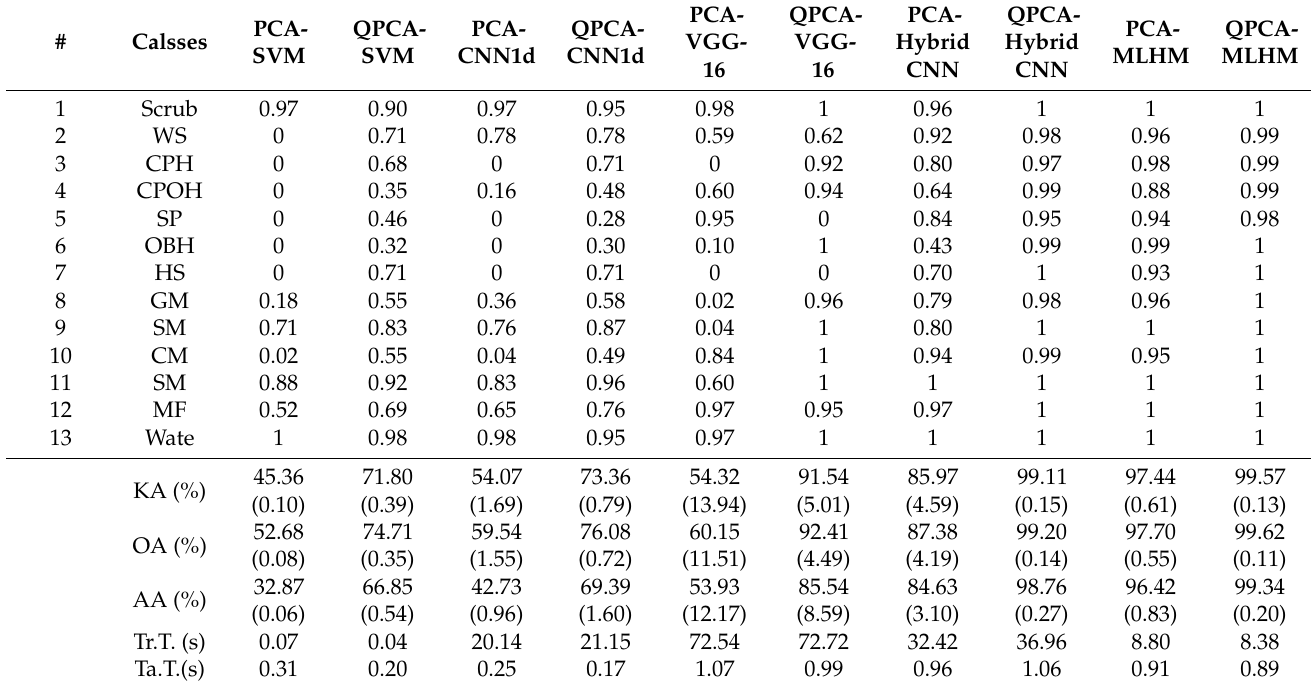
Table 8. The comparison of the various models with PCA and QPCA preprocessing for the KS_center